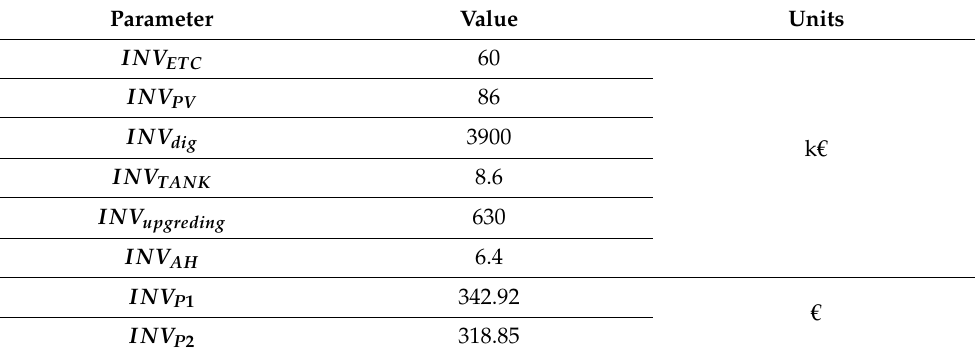
Table 5. Capital costs.